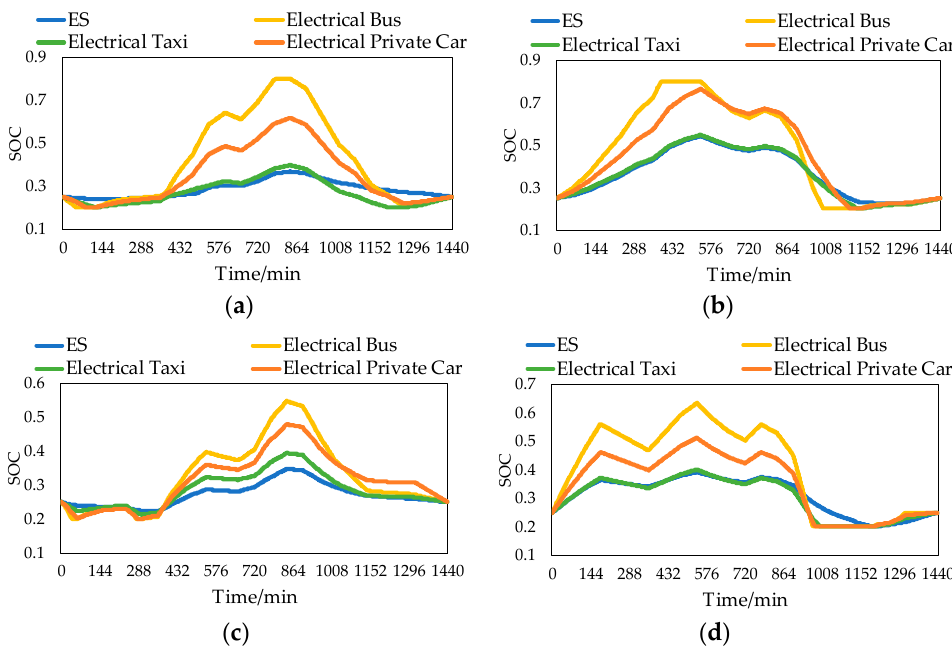
Figure 5. SOC results of ES and EV. ( a ) Spring. ( b ) Summer. ( c ) Autumn. ( d ) Winter.